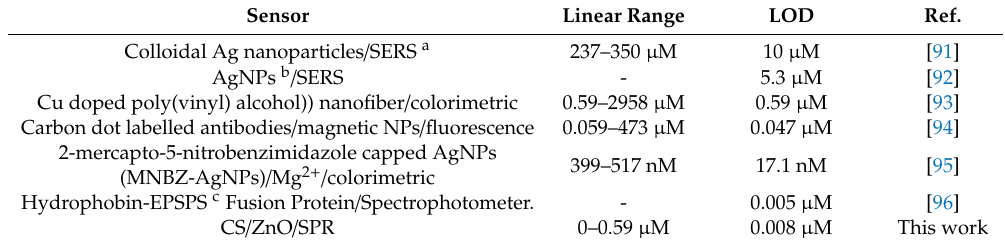
Table 1. Comparison of the CS / ZnO sensor with other optical methods for glyphosate detection. Sensor